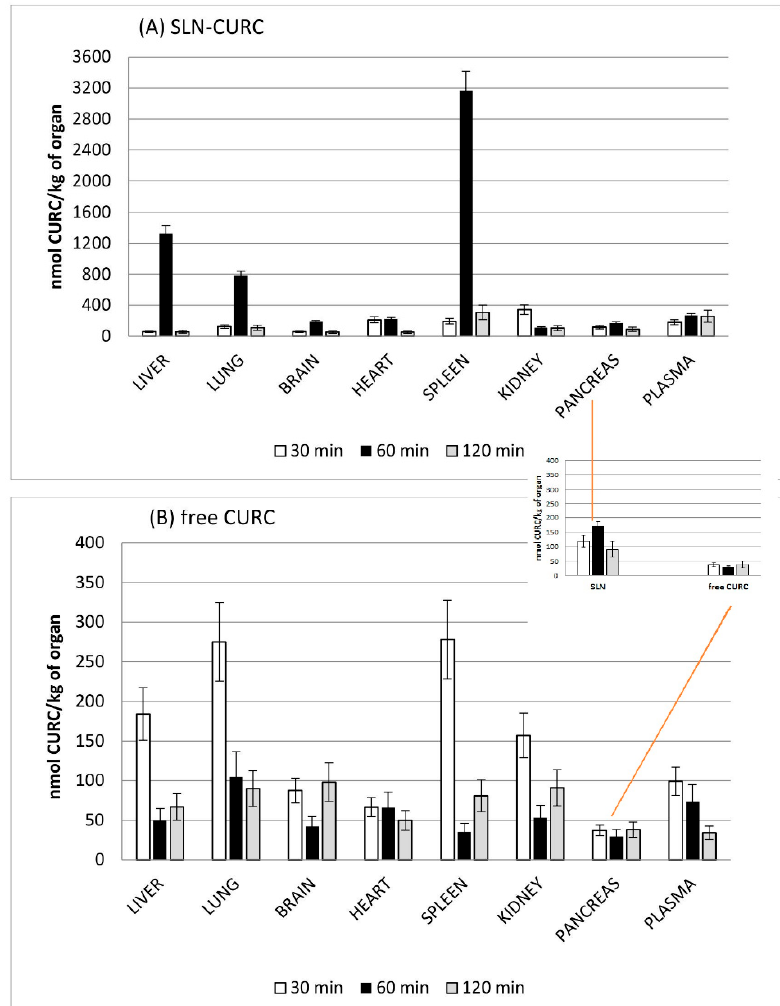
Figure 7. Biodistribution profile over time for each organ of CURC in SLN-CURC ( A ) and free CURC ( B